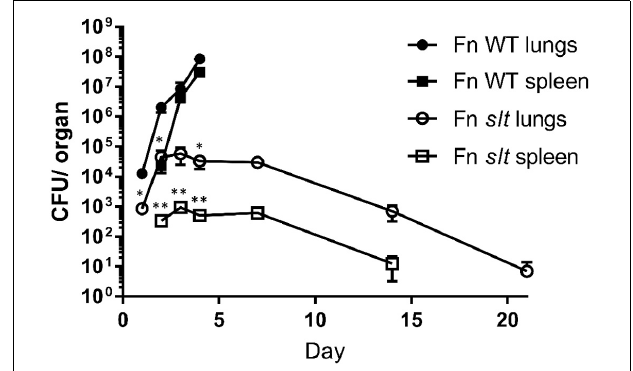
FIGURE 8 | Dissemination of F. novicida WT and slt strains during intranasal challenge. BALB/c mice were infected intranasally with 42 CFU WT or 52 CFU slt mutant. At days 1, 2, 3, 4, 7, 14, and 21, mice were euthanized and lungs and spleens were harvested. Serial dilution and plating of homogenized lung and spleen were performed to determine recovery of bacteria. Results are shown as CFU per organ based on 5 mice per time point, except for day 4 WT; only four Fn WT-challenged mice remained and the rest had succumbed to infection. Error bars represent standard error of the mean; ∗∗ P < 0.001, average CFU/spleen days 2, 3, 4; ∗ P < 0.05 average CFU/lung days 1, 2, 4, as assessed by t -test. WT-infected mice were only carried out until day 4,